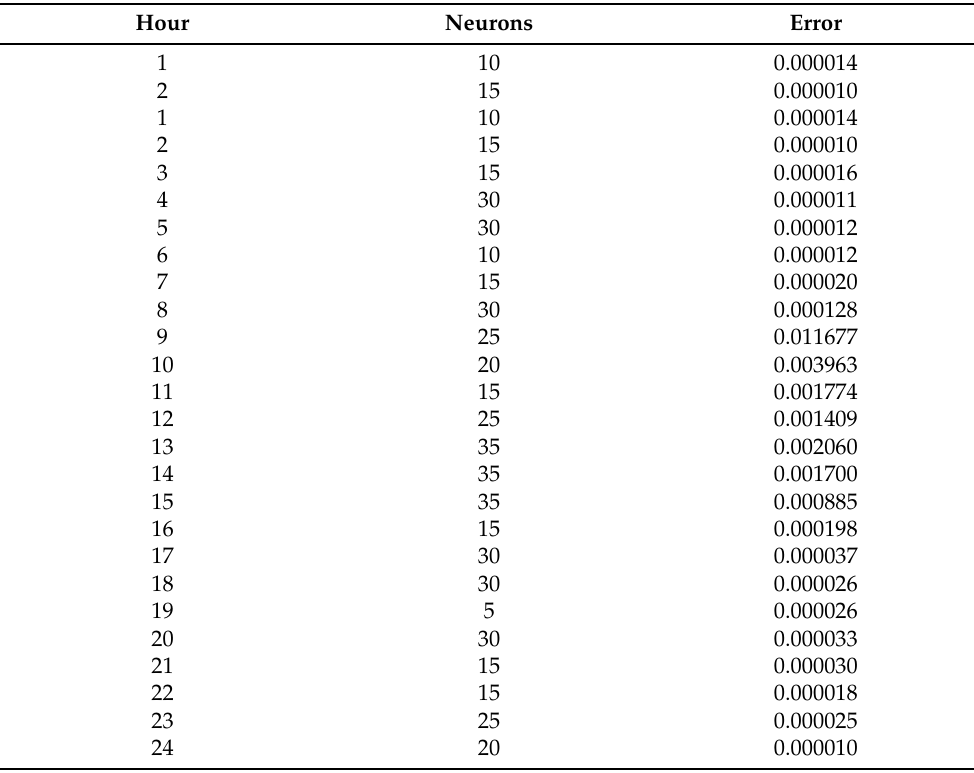
Table 6. Example of the errors obtained from each specialized model of one of the buildings.